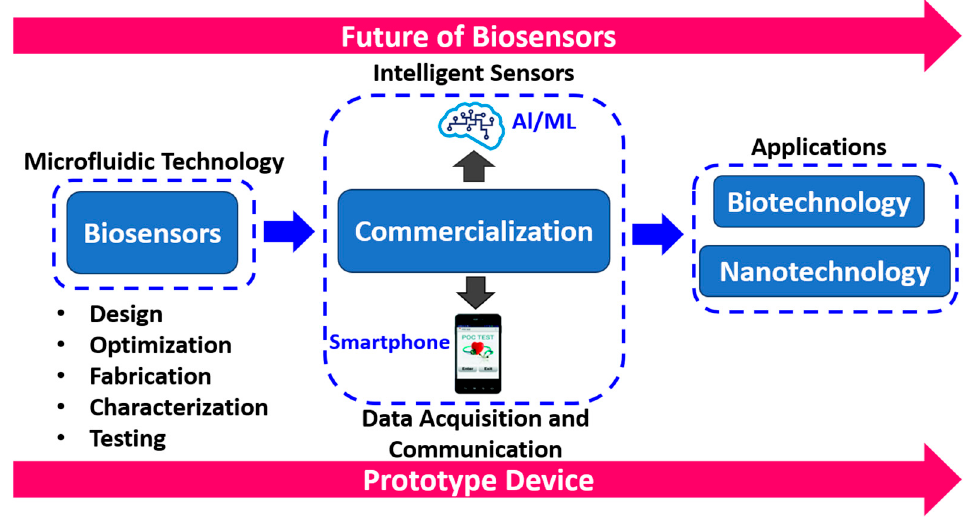
Figure 13. Future scope of biosensors.